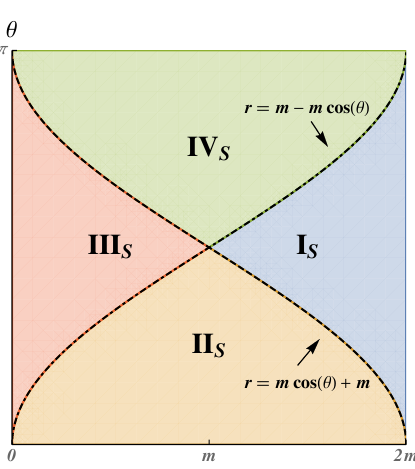
Figure 5. Bijection to quadrangle in ( r; cos (cid:18)